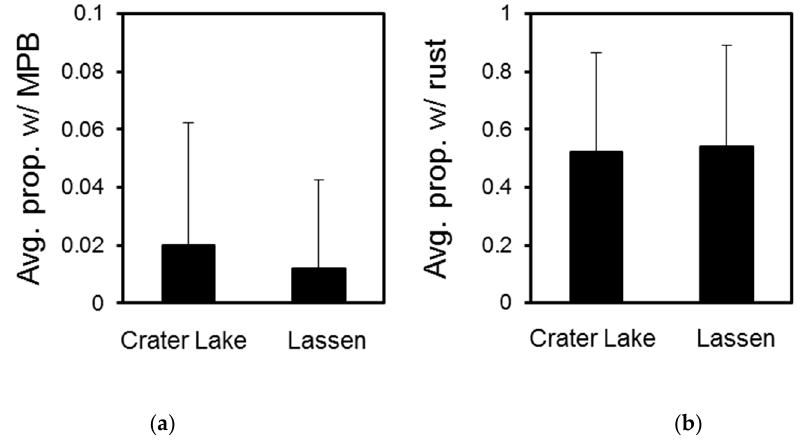
Figure 8. ( a ) Incidence of mountain pine beetle and ( b ) white pine blister rust from 30 whitebark pine plots in Crater Lake (CRLA) and Lassen Volcanic (LAVO) National Parks. Means with ± SD are shown. Here, rust is blister rust and MPB is mountain pine beetle.